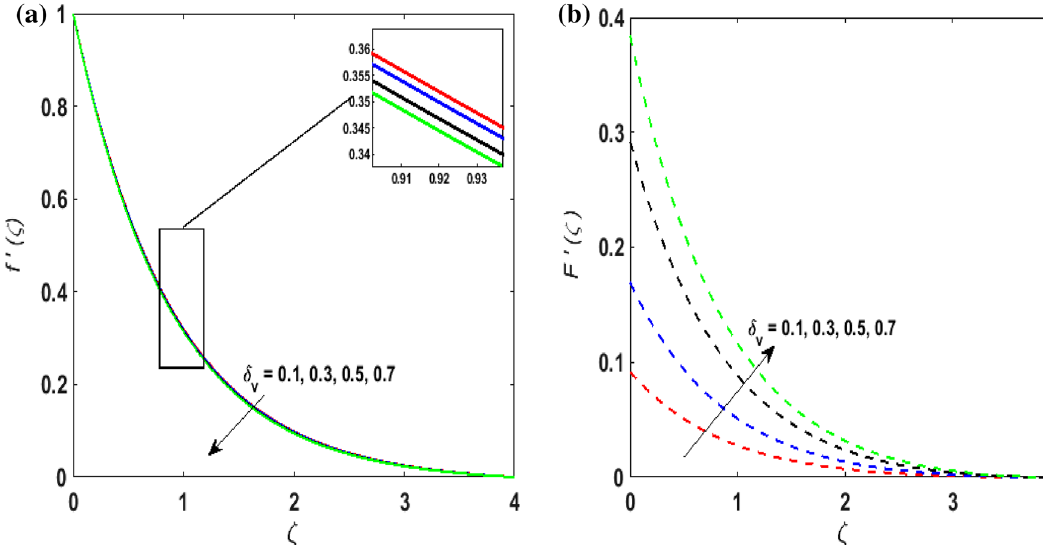
Figure 6. ( a ) f ′ (ζ) for various δ v . ( b ) F ′ (ζ) for various δ v .